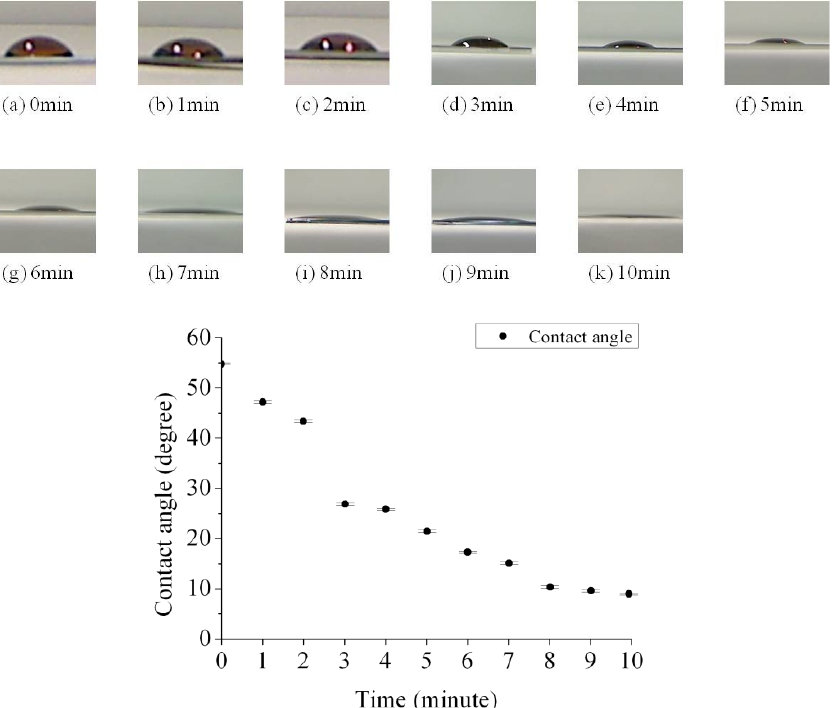
Figure 4. The contact angle between the protein solution and the SU-8 photoresist surface after surface modification. The contact angle decreases with increased treatment time. The surface is more hydrophilic.